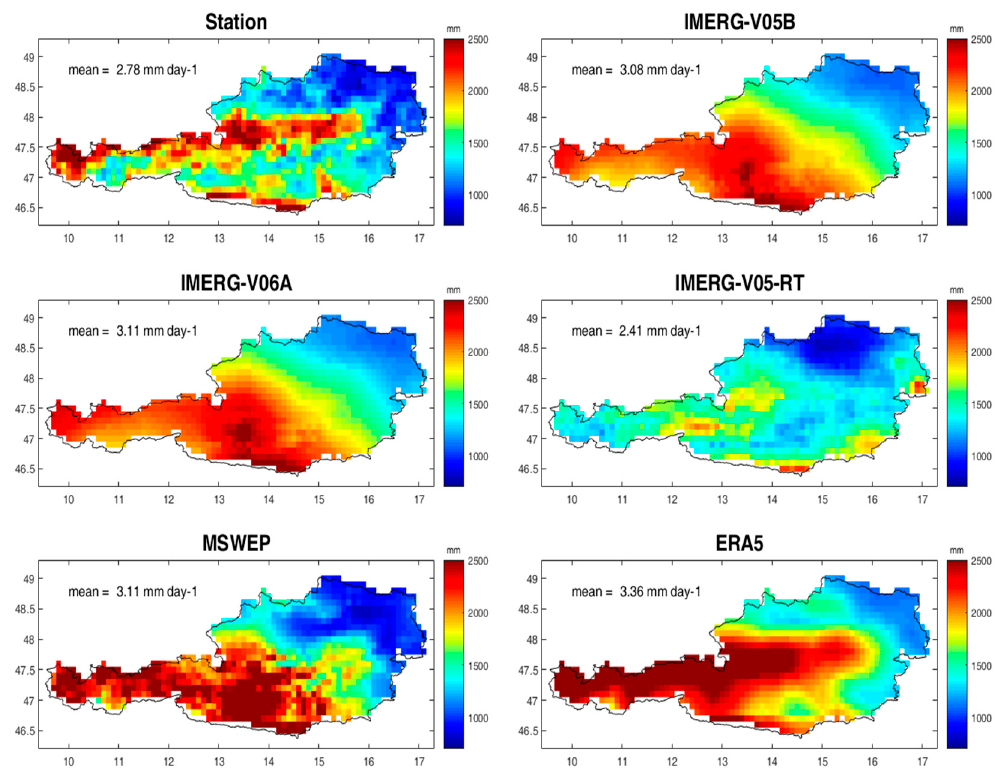
Figure 9. Spatial distribution of accumulated precipitation (mm) from June 2014 to December 2015 by stations, IMERG-V05B, IMERG-V06A, IMERG-V05-RT, MSWEP, and ERA5.